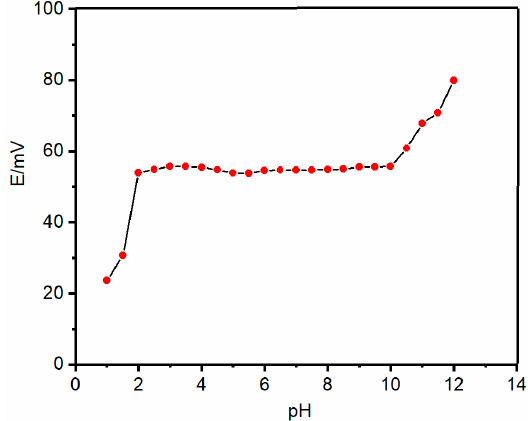
Figure 10. The stability of the Br-ISE was continuously calibrated in 10 − 3 M KBr solution for 8 h.